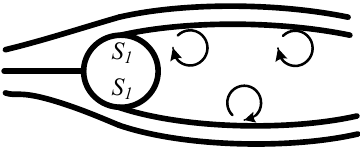
Figure 1. Schematic of Karman Vortex Street.